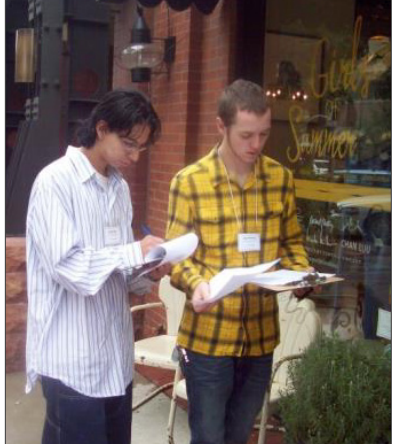
Figure 2. Business Action Group collecting data on youth-friendly businesses (photo courtesy of Growing Up Boulder